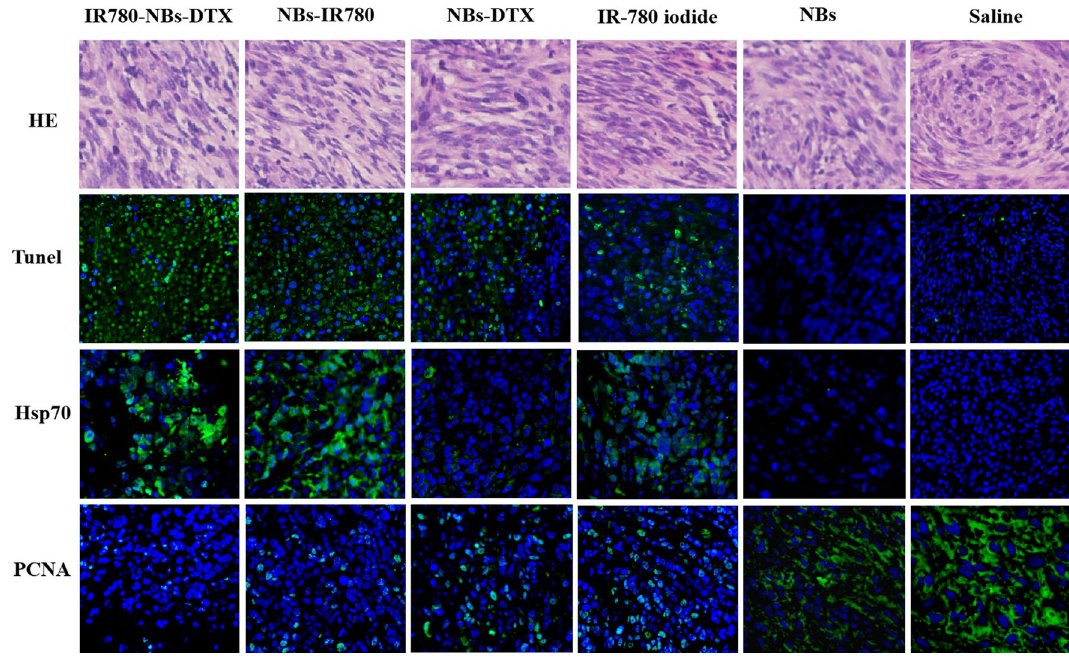
Figure 15. Molecular-level observation of the tumor therapeutic effect mediated by different contrast agents (IR780-NBs-DTX, NBs-IR780, NBs-DTX, IR-780 iodide, NBs, and saline) through immunohistochemistry and immunofluorescence ex